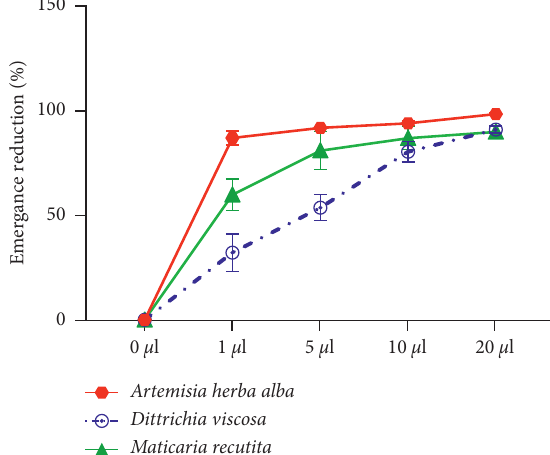
Figure 12: Rate of the fertility reduction in females under the effect of EOs.